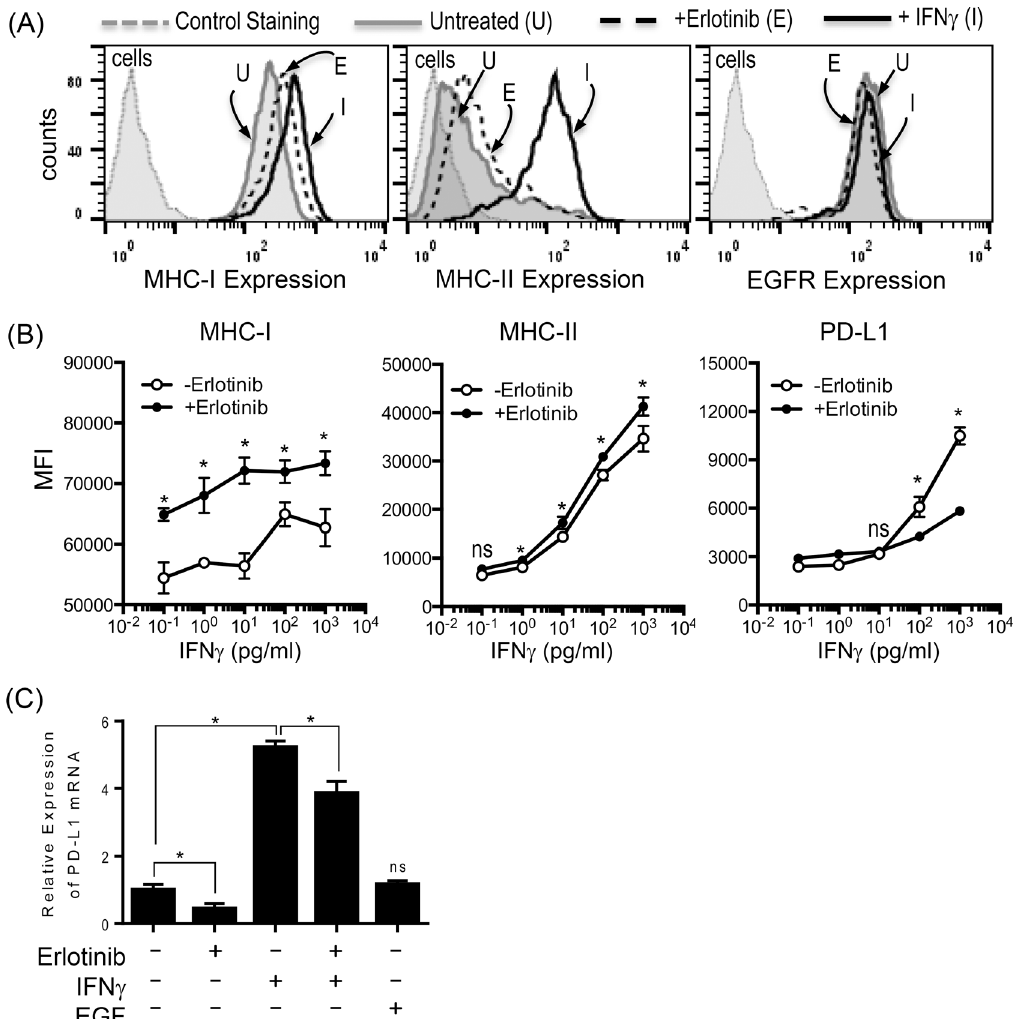
Fig 1. EGFR inhibitor differentially modulates the expression of antigen presenting molecules and PD-L1 on HaCaT cells. (A) HaCaT cells were treated with IFN γ at concentration of 1000 pg/ml or erlotinib at concentration of 20 μ M for 24 hours, and assessed for surface expression of MHC-I, MHC-II, and EGFR. Erlotinib up-regulated the expression of MHC-I on HaCaT cells while IFN γ upregulated both MHC-I and MHC-II. Neither treatments affected EGFR expression. Gray dotted line: unstained HaCaT cells, gray solid line: untreated HaCaT cells stained for MHC-I, MHC-II, or EGFR. Black dotted line: erlotinib treated HaCaT cells stained for MHC-I, MHC-II, or EGFR. Black solid line: IFN γ treated HaCaT cells stained for MHC-I, MHC-II, or EGFR. (B) HaCaT cells were treated with IFN γ at different concentrations ranging 1 pg/ml to 1000 pg/ml in the presence or absence of erlotinib at concentration of 10 μ M for 24 hours, and assessed for surface expression of MHC-I, MHC-II, and PD-L1 in Mean Fluorescence Intensity (MFI). While the expression of MHC-I and MHC-II on HaCaT cells was further up-regulated in the presence of erlotinib and IFN γ at all dose range tested for MHC-I and at a greater than 1pg/ml for MHC-II compared to IFN γ alone, IFN γ induced overexpression of PD-L1 was abrogated by the addition of erlotinib to IFN γ at a greater than 100 pg/ml. The experiment shown here was performed in triplicates, and a representative of three independent experiments.(C) A total RNA from HaCaT cells treated with or without erlotinib, IFN γ , or EGF was assessed for the relative expression of PD-L1 transcripts via Reverse Transcription quantitative Polymerase Chain Reaction (RT- qPCR) in quadruplicates. Erlotinib treatment resulted in statistically significant decrease in PD-L1 transcripts on HaCaT cells P-value less than 0.05 ( * ) was determined as being statistically significance. “ NS ” represent “ statistically not-significant ”